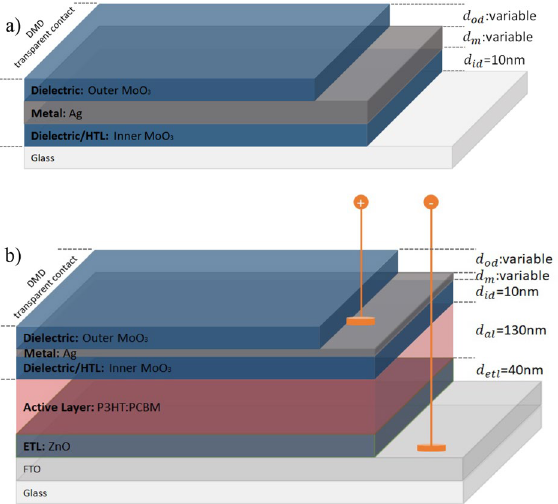
Figure 14. Schematic representation of ( a ) MoO 3 /Ag/MoO 3 DMD transparent top contact and, ( b ) FTO/ZnO/ P3HT:PCBM/MoO 3 /Ag/MoO 3